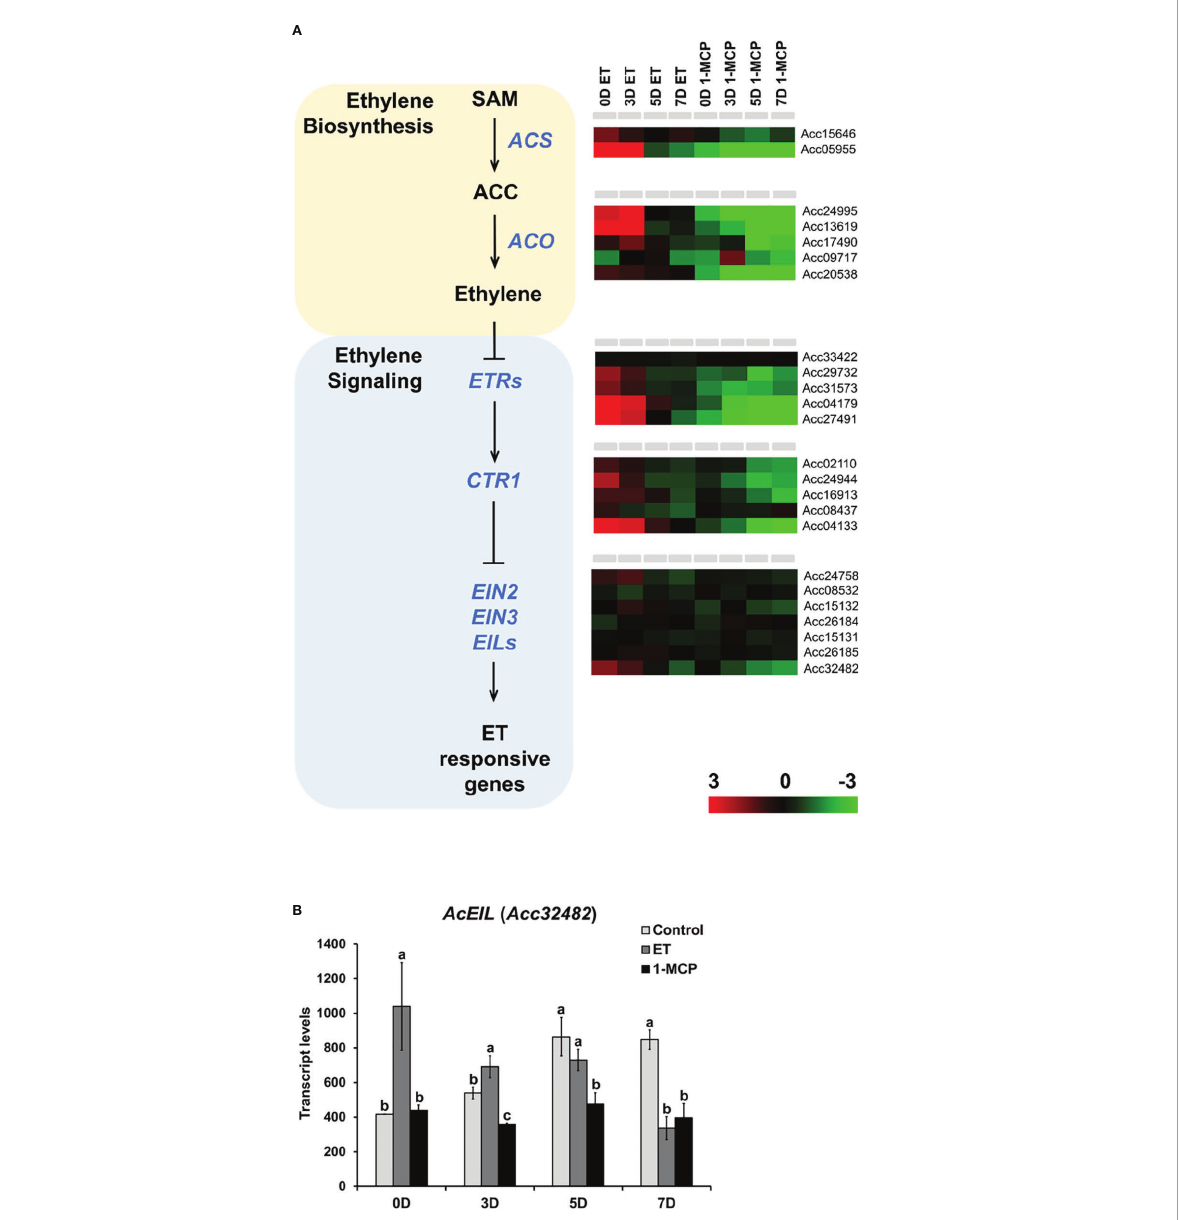
FIGURE 8 Expression pro fi les of ET signaling and biosynthesis pathway genes upon ET and 1-MCP treatment along ripening time course. (A) Schematic diagram showing ET biosynthesis (pink box) and ET signaling (blue box) beginning from a precursor, S-adenosyl methionine (SAM). Gene names responsible for each step of ET biosynthesis and signaling pathway were indicated with italicized blue-colored letters. Expression levels of genes related to each step of ET biosynthesis and signaling pathway were presented as a heatmap. Red cube represents upregulated gene expression, and green cube represents downregulated gene expression compared to the level of the control sample. ET, ethylene; 1-MCP, 1- methylcyclopropene. (B) Transcript levels of AcEIL (Acc32482) in the control, ET-treated, and 1-MCP-treated samples along four different time course (0D, 3D, 5D, and 7D). ET, ethylene; 1-MCP, 1-methylcyclopropene. Data represent the mean of the transcript values from three biological replicates with error bars showing standard deviation (n=3). One-way ANOVA and post-hoc Tukey ’ s test (p < 0.05) was applied to calculate the statistical signi fi cance, and signi fi cant difference was indicated in the fi gures by different letters (p <